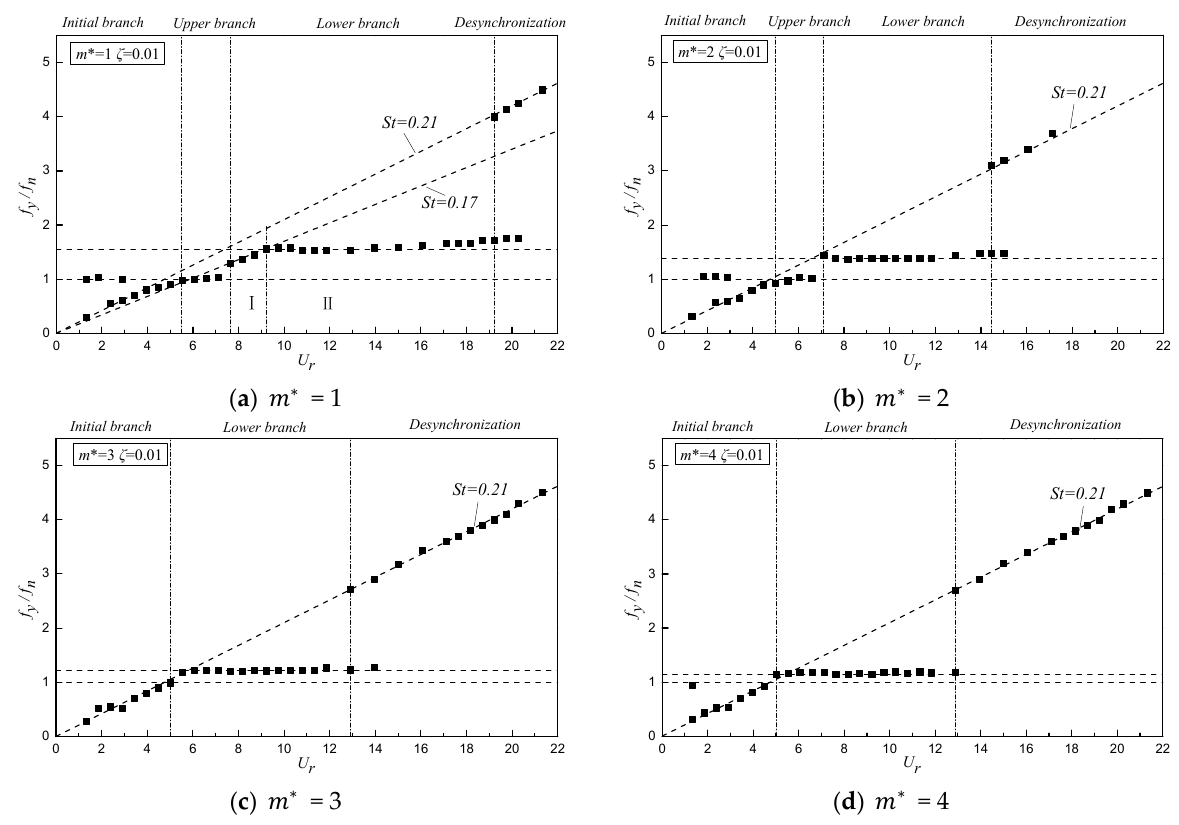
Figure 9. The frequency ratio ( f y / f n ) of the cylindrical oscillator under different mass ratios changes with Ur.